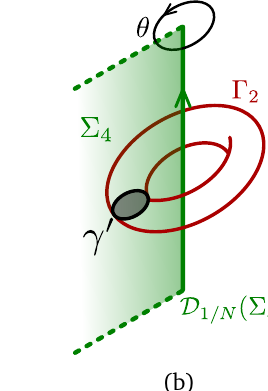
Figure 1: a) A non-invertible topological operator D